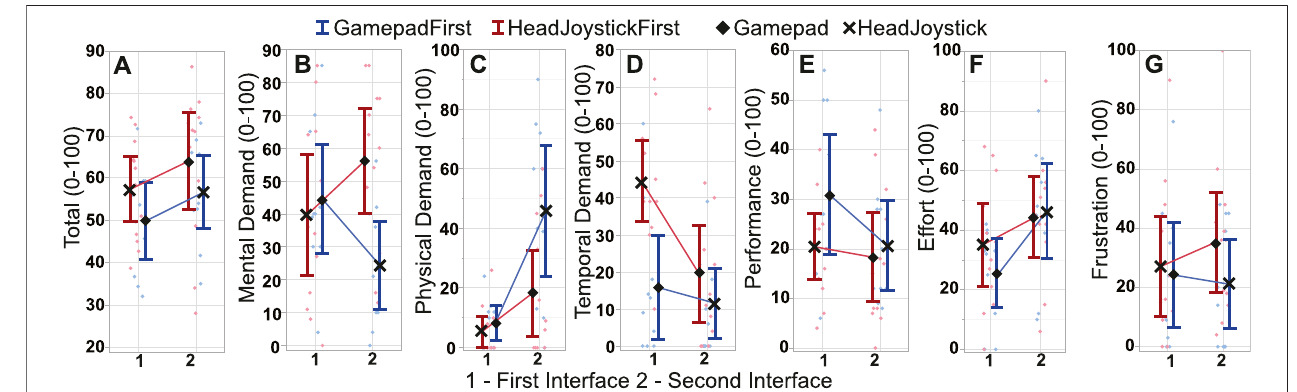
FIGURE 8 | NASA TLX in %, after using the fi rst interface then second interface. The blue line and red line indicate participants using Gamepad and HeadJoystick respectively, for their fi rst trial. A (cid:2) Gamepad interface, X (cid:2) HeadJoystick interface, CI (cid:2)